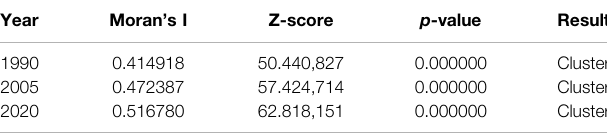
TABLE 11 | Spatial autocorrelation analysis results of ecosystem resilience in Nanchang city.